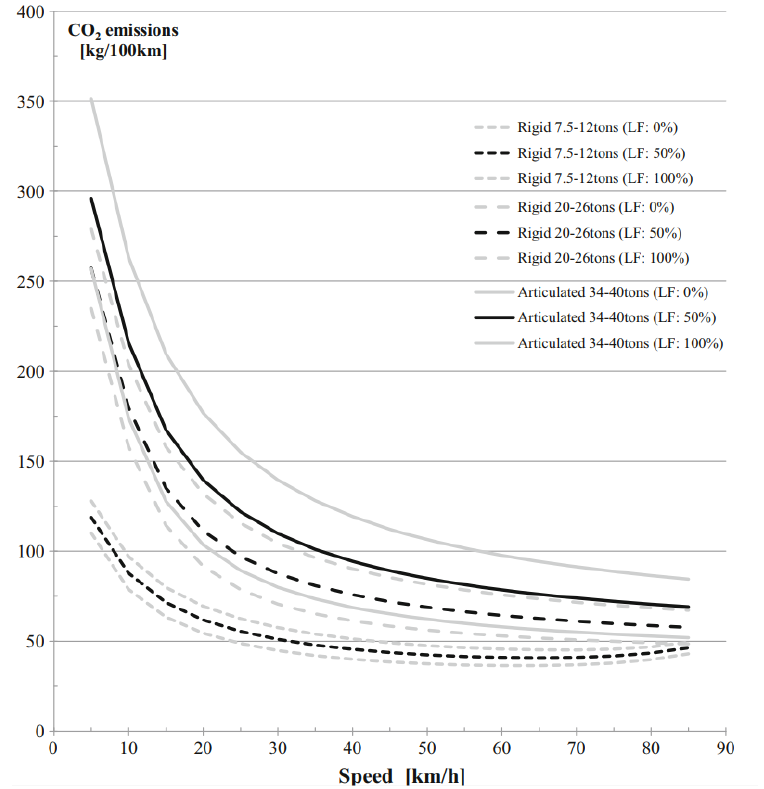
Figure 1. Vehicle speed and CO 2